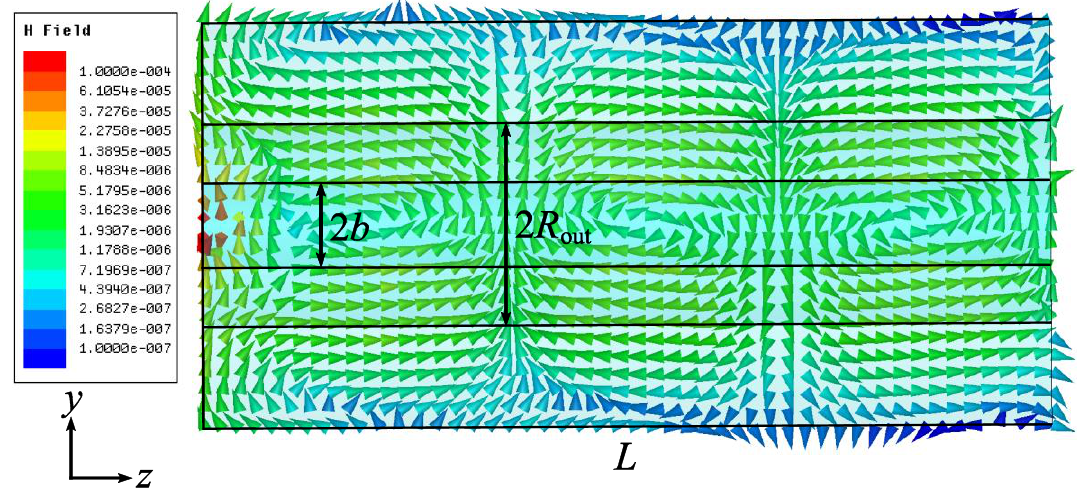
Figure 11. Re{ H(x,y,z) }, phase dependent magnetic vector field in the yz